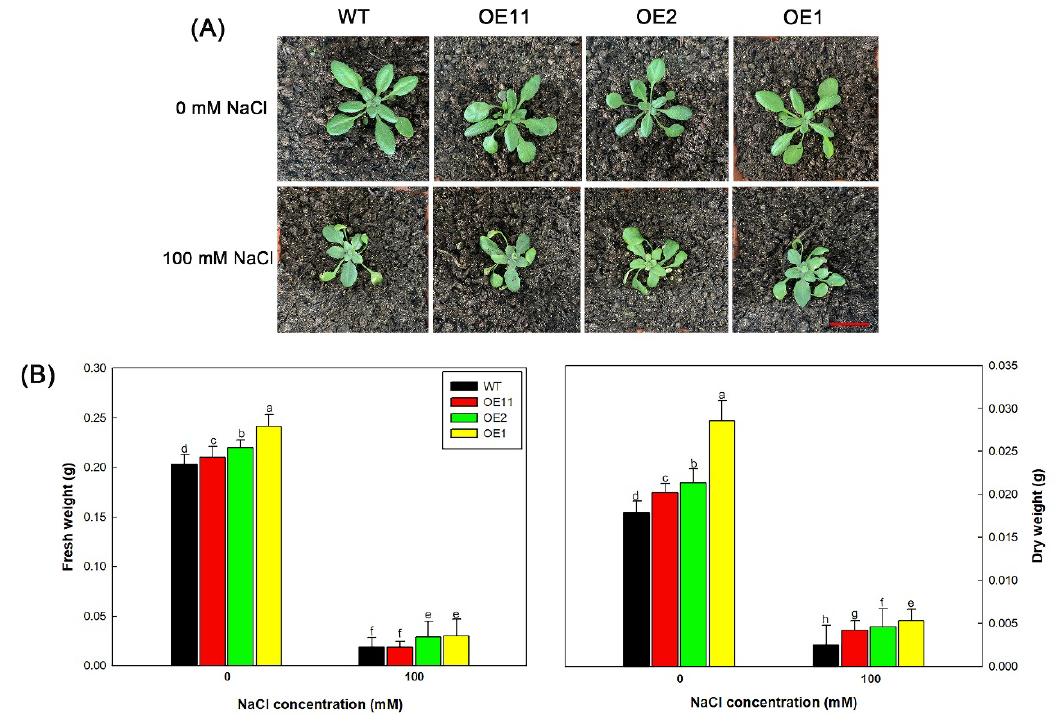
Figure 5. Lb1G04202 increased the salt resistance of Arabidopsis at the seeding stage. ( A ) Growth of transgenic seedlings treated with Hoagland solution containing different concentrations of NaCl (0 and 100 mM). Bar = 2 cm. ( B ) Fresh weight and dry weight of complete plant seedlings under different NaCl treatments. Data are means ± SD of four replicates; different letters indicate significant differences at p = 0.05 according to Duncan’s multiple range test.